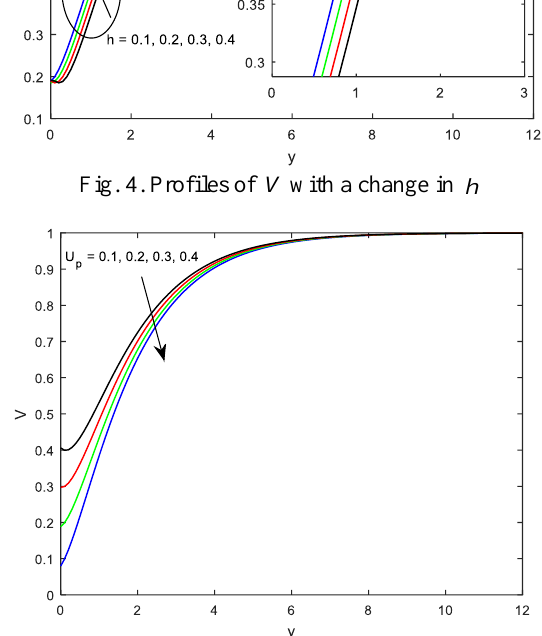
Fig. 5. Profiles of V with a change in